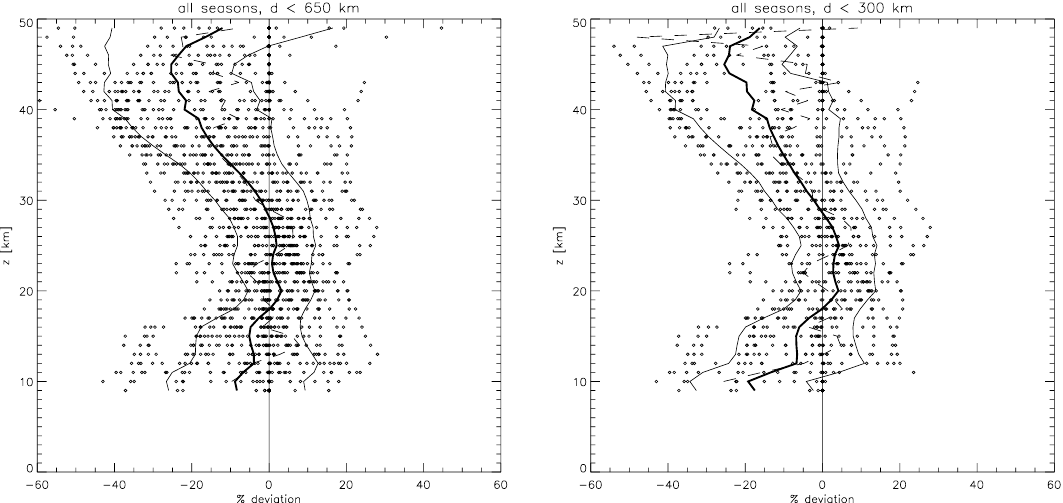
Fig. 3. Relative deviation [%] between GOME and convolved lidar profiles ( { GOME-lidar } /lidar) of all profiles within a 650km radius around ALOMAR (left panel) and within a 300km radius (right panel). Solid bold line: average deviation; thin solid lines: standard deviations; dots: single profile deviations. Dashed line: average deviation using original (unconvolved) lidar